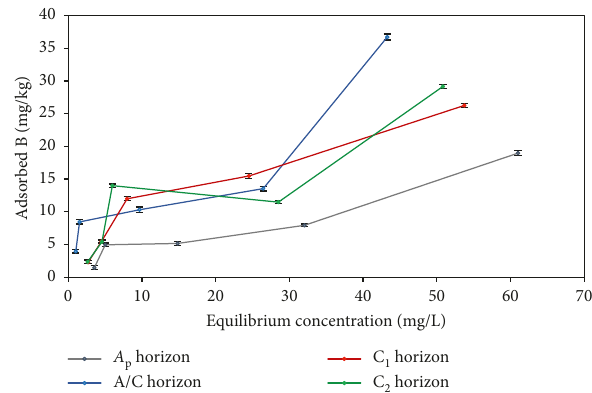
Figure 3: Amounts of the adsorbed B of the different horizons of the studied soil.